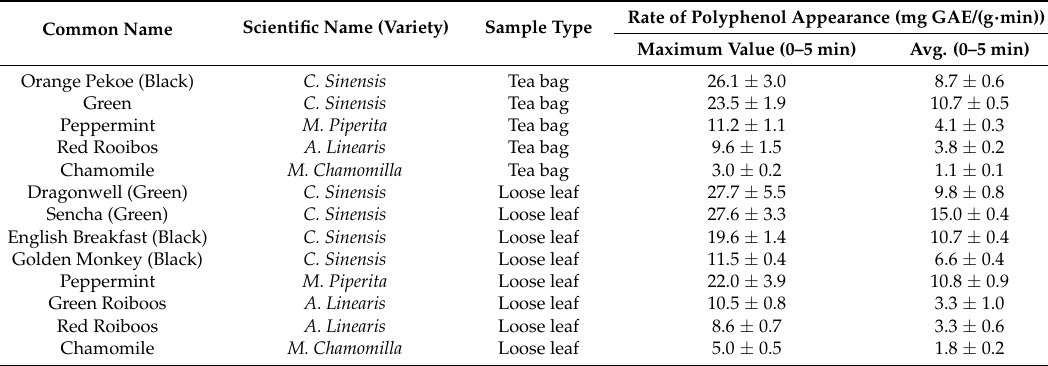
Table 2. Rate of polyphenol appearance from tea bags and loose-leaf